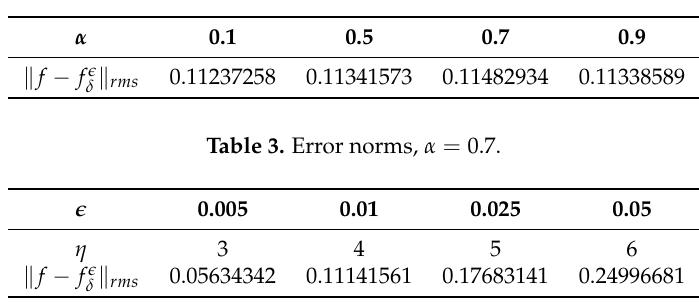
Table 2. Error norms, (cid:101) = 0.025 and η = 5.